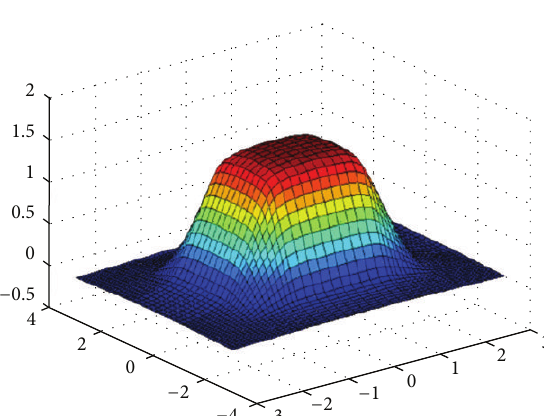
Figure 20: Positivity preserving by using the study of Hussain and Sarfraz [12] for positive data in Table 6.